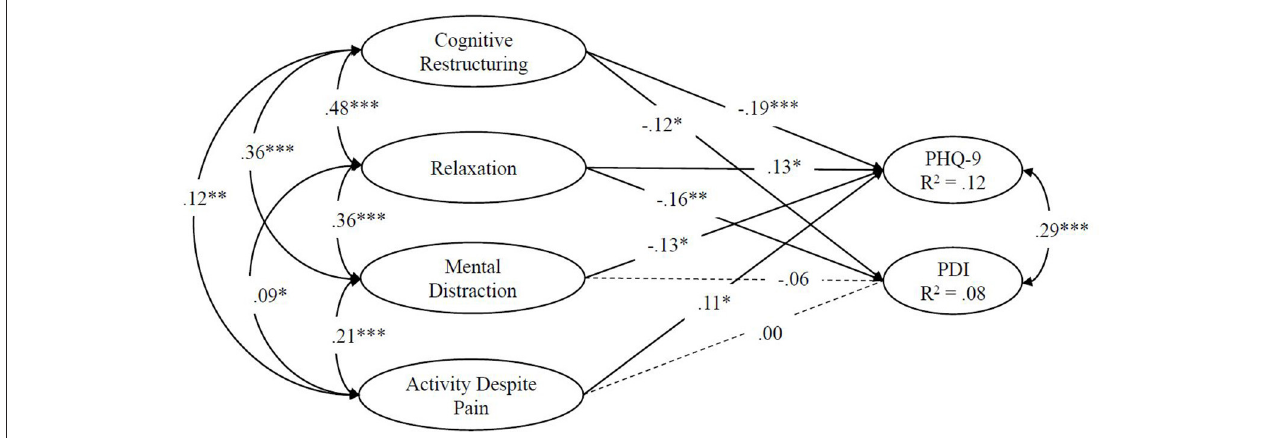
FIGURE 1 | Regressions in a structural equation model on the associations between single indicator latent changes in pain coping skills and changes in disability in Model 1 (clinic A); PDI, Pain Disability Scale; * p < 0.05, ** p < 0.001, *** p < 0.00001; estimation with full maximum likelihood; n = 754.